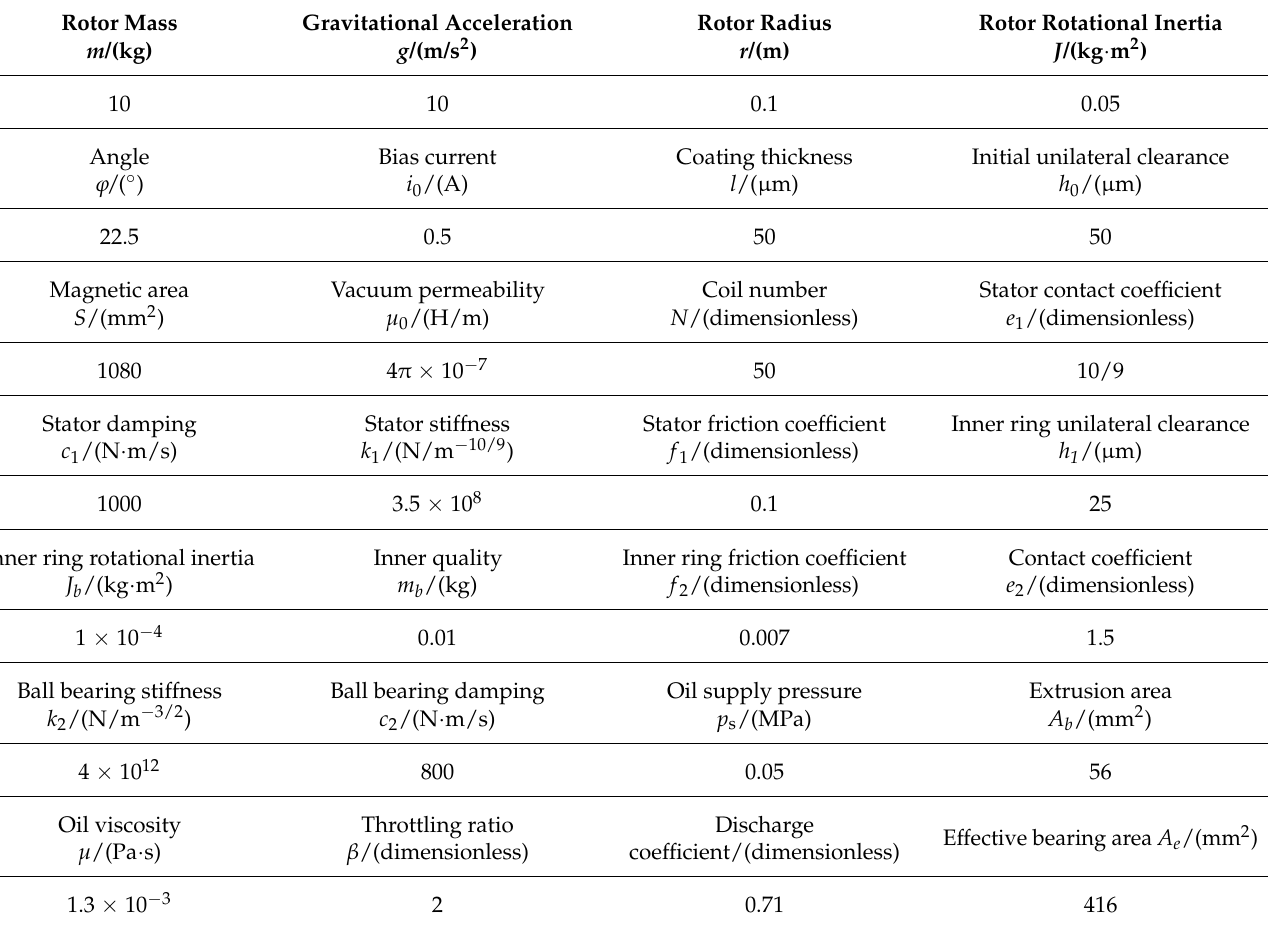
Table 1. Initial design parameters of the protection device.